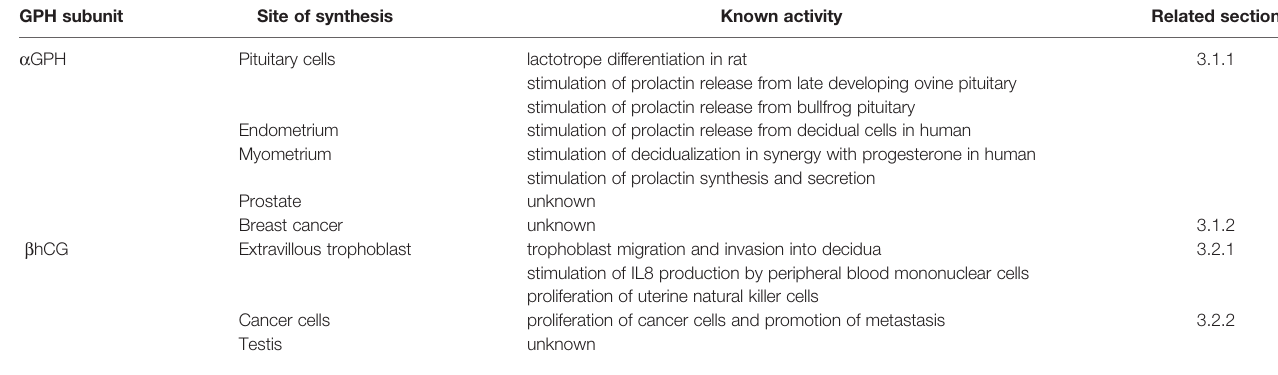
TABLE 1 | Individual subunits sites of synthesis and